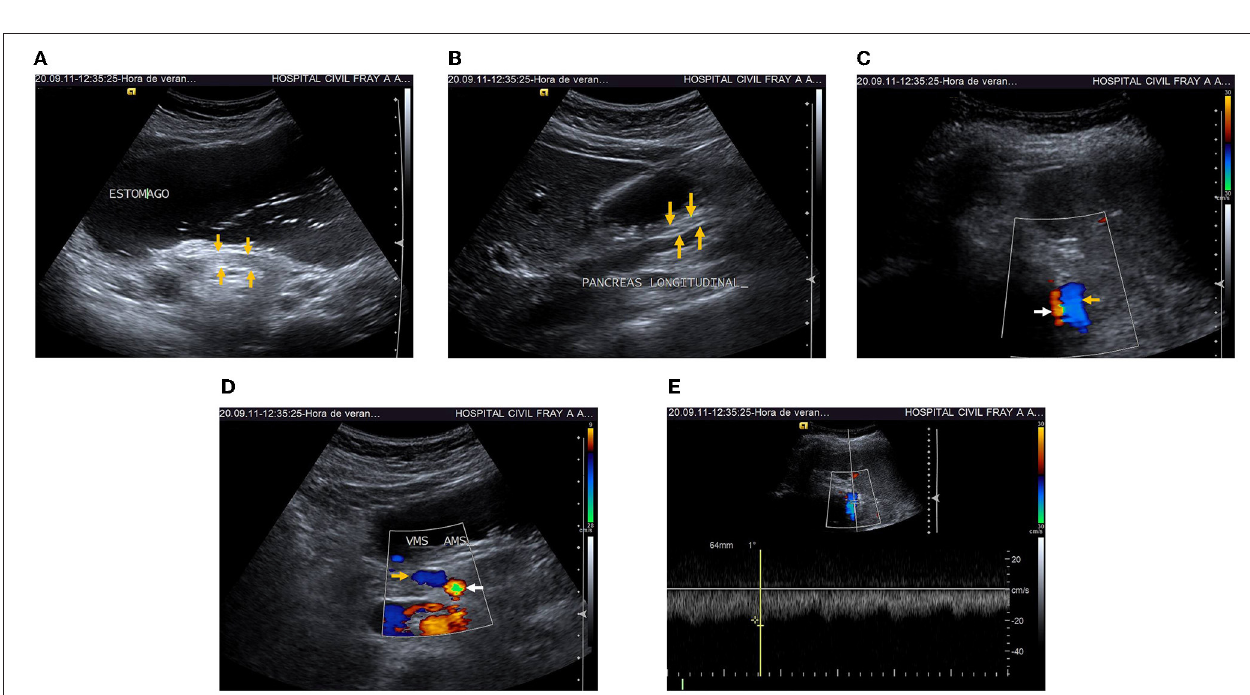
FIGURE 2 | (A) 16-month follow-up transverse US showed thin pancreatic head and tail (arrows) and absence of fluid collections. (B) Longitudinal US showed thin pancreatic head and tail (arrows), absence of fluid collections. (C) Doppler-Ultrasonography (DUS) at 16-month follow-up showed resolution of SplVT (yellow arrow) and normal splenic artery (white arrow). (D) DUS showed complete resolution of SMVT (yellow arrow), and normal superior mesenteric artery (white arrow). (E) Pulsed-DUS, normal velocity in splenic vein (23.5